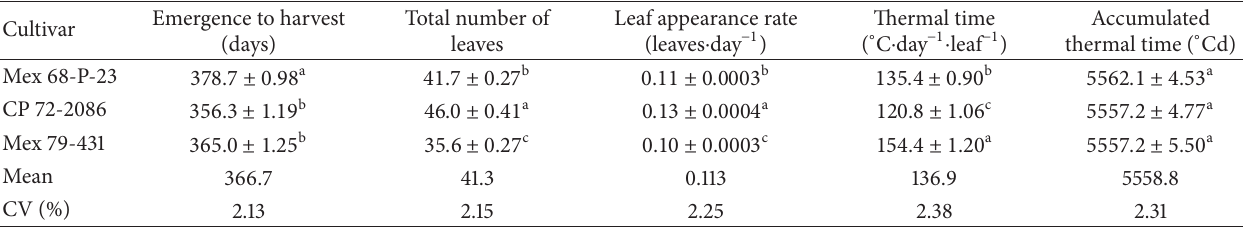
Table 1: Days from emergence to harvest, total number of leaves, leaf appearance rate, thermal time, and accumulated thermal time ( ± standard error) for three sugarcane cultivars in Northeastern Mexico under high temperature rainfed conditions. Cultivar